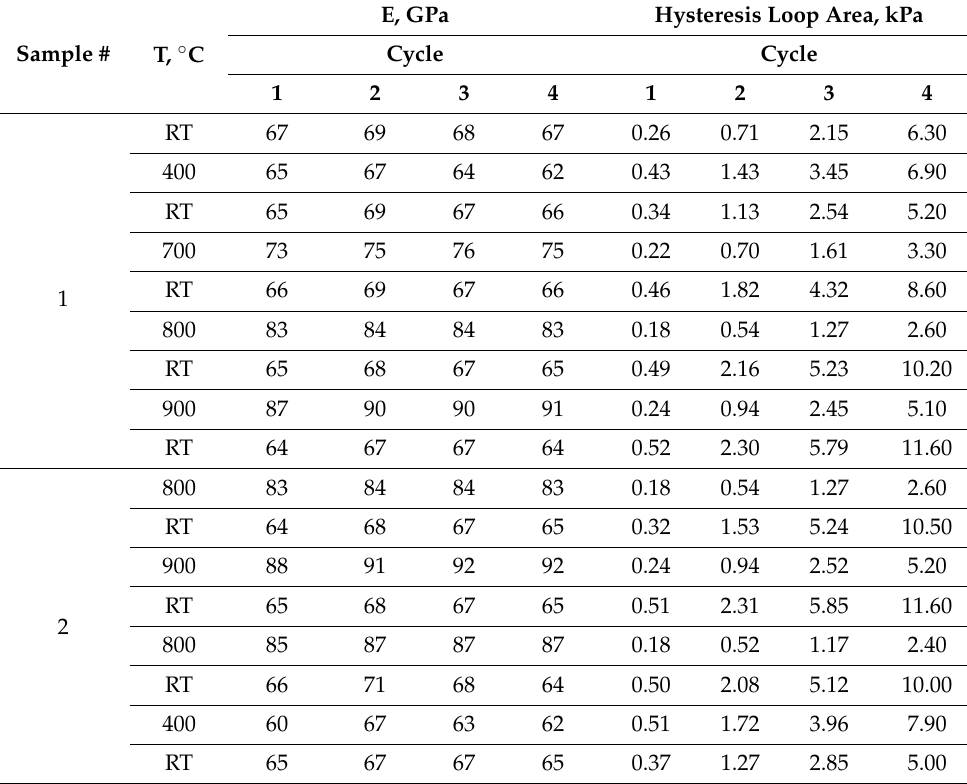
Figure 2. Stress–strain deformation plots of LaCoO 3 sample #1 ( A ) and sample #2 ( B ) showing the corresponding heating history of the cyclic loading. The stress–strain plots performed at elevated temperatures are shown using a solid line, while room temperature stress–strain deformation plots collected after corresponding high temperature experiments are shown with a dotted line. Table 2. Young’s moduli and hysteresis loop areas of two LaCoO 3 samples calculated at four different loading/unloading cycles at different temperatures.